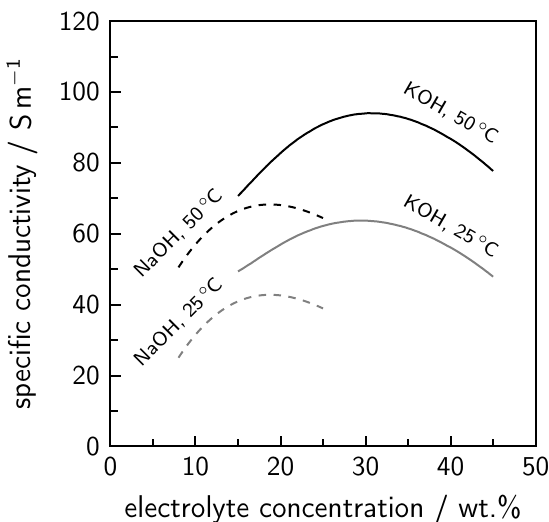
Figure 5. The calculated specific electrolyte conductivity as a function of the electrolyte concentrations of sodium hydroxide (NaOH) and potassium hydroxide (KOH) solutions at different temperatures obtained by Equations (A2) and (A3). The correlation parameters can be found in Table A2